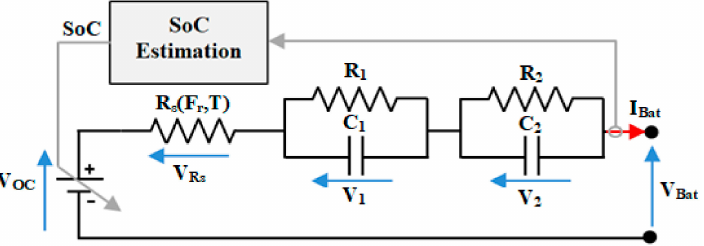
Figure 2. Electric behavioral model of the LiFePO4